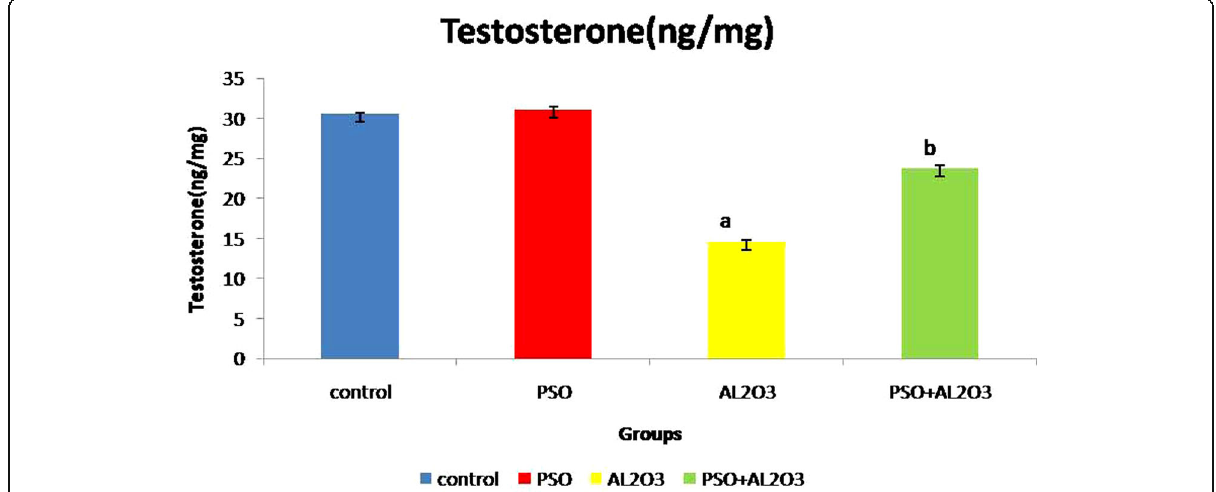
Fig. 3 Effect of pumpkin seed oil on serological testosterone level in AL 2 O 3 -NP administrated rat. (a) Significant change from the control rat. (b) Significant change from the AL